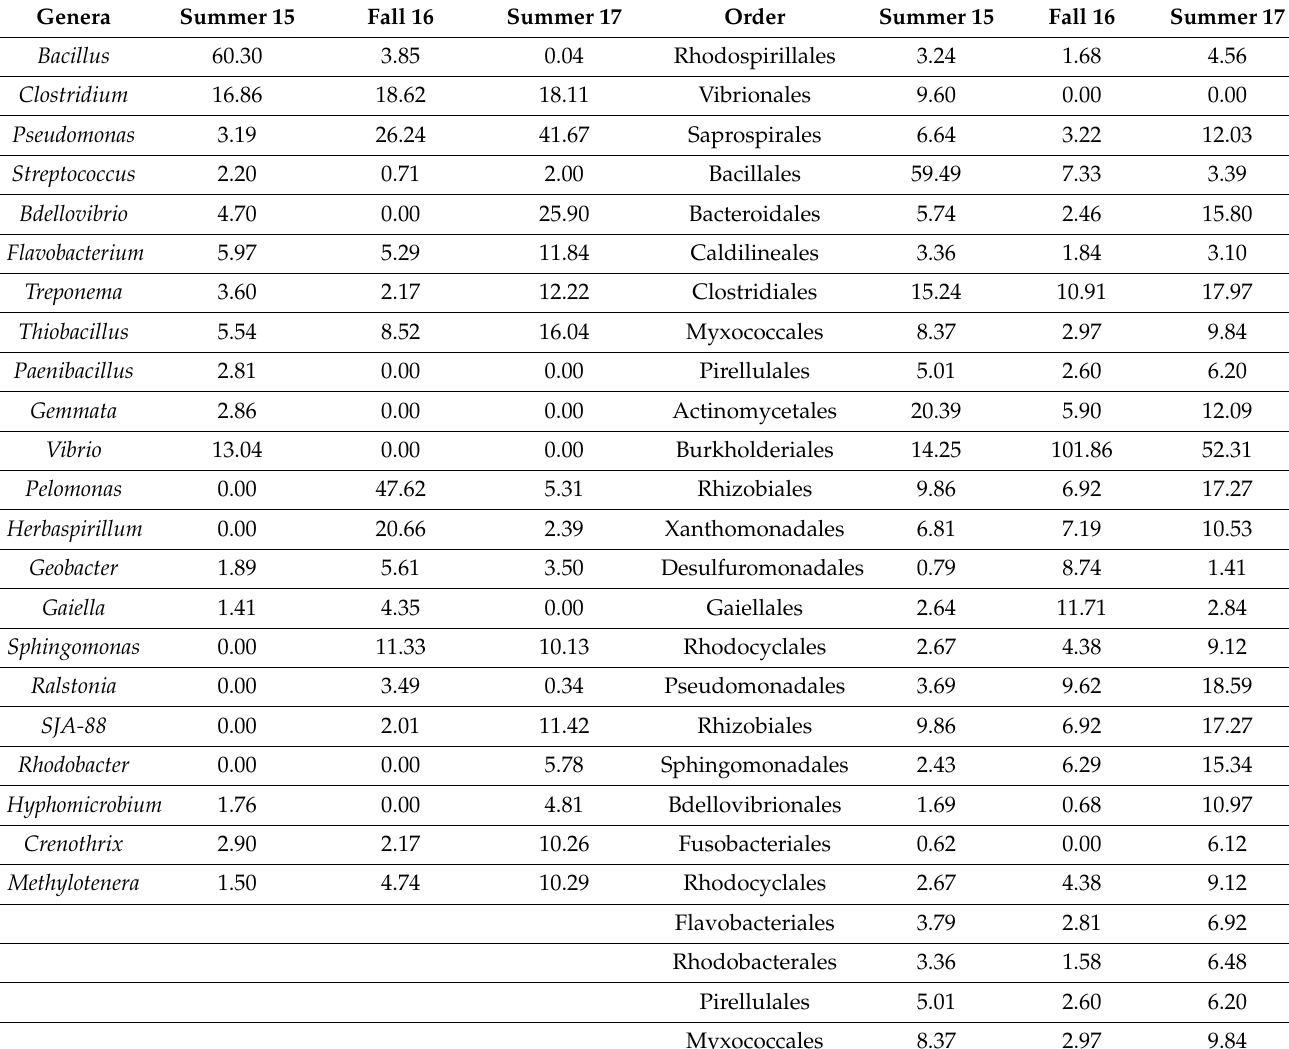
Table A1. The relative abundance of some of the most abundant bacterial orders and genera identified in the collected wetland sediments during summer 2015, fall 2016, and summer 2017, identified by 16S rRNA gene sequencing in wetland sites 1, 2, 4, 5, and